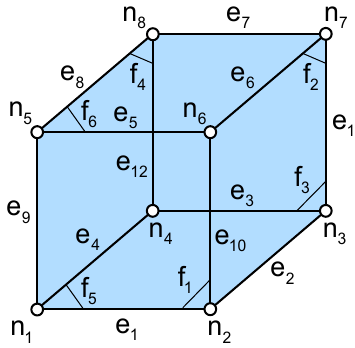
Figure 3. Topological domains of a unit cube c 1 .